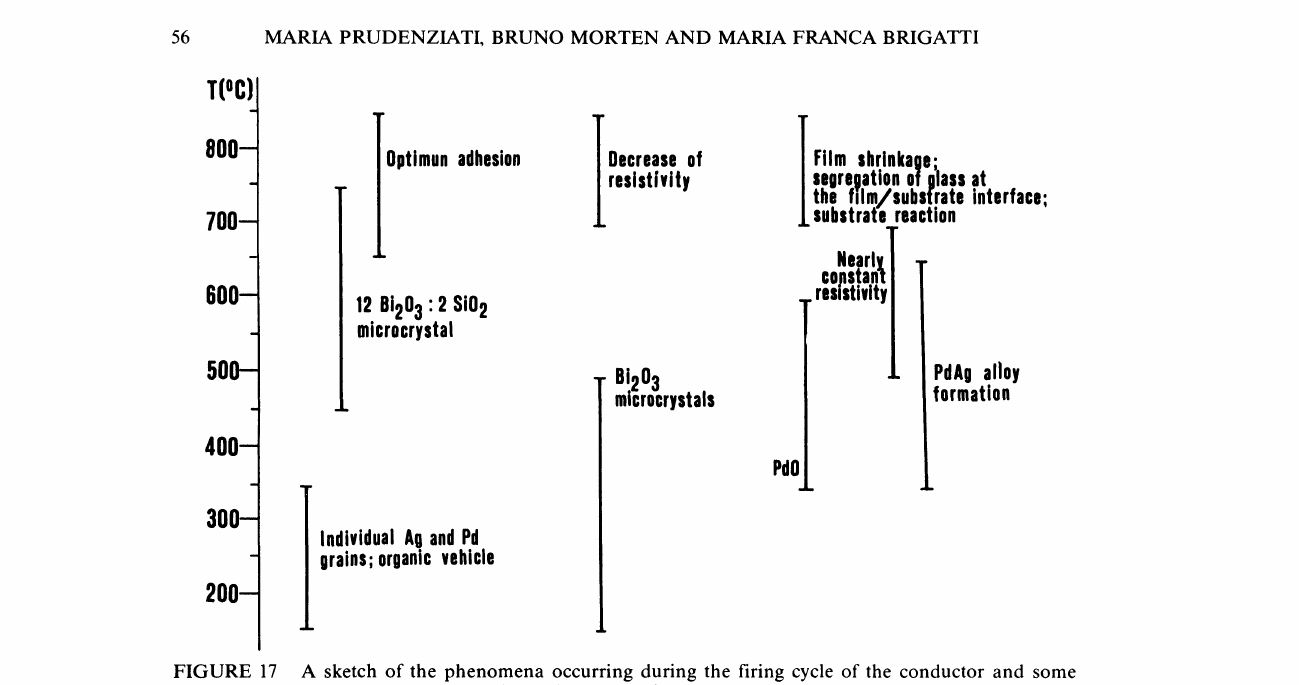
FIGURE 17 A sketch of the phenomena occurring during the firing cycle of the conductor and some correlation of these phenomena with the performance of the